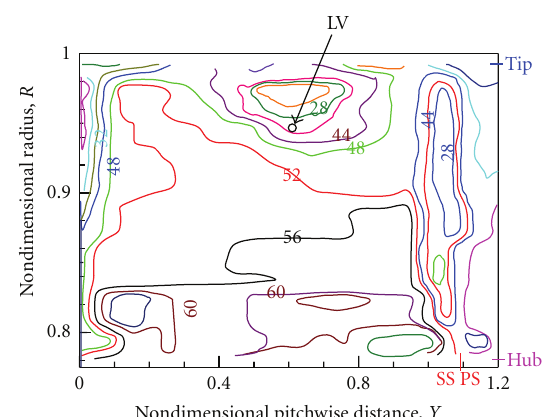
Figure 12: Relative flow angle contours at the exit of rotor (wos) for φ = 0 . 55.